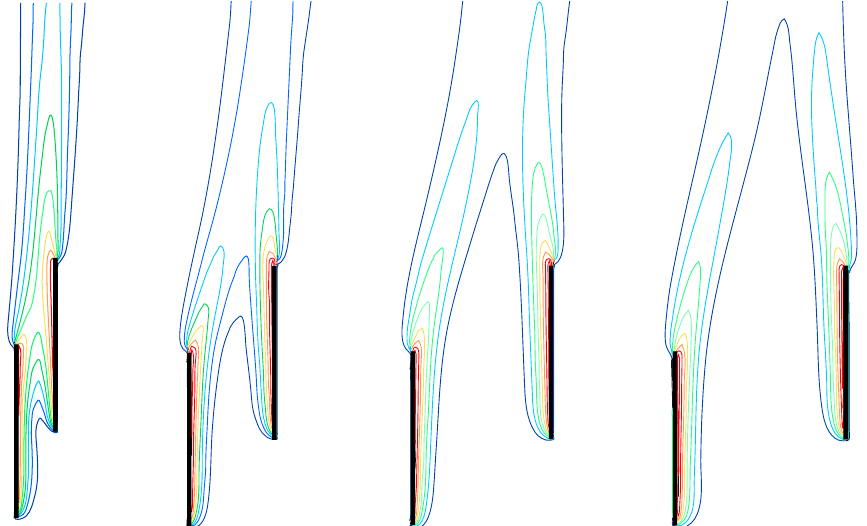
Figure 4. Isotherm contour plots for Ra H = 10 5 , L / H = 0.5 and W / H = 0.25, 0.5, 0.75, 1 using a scale from blue ( T = 0 ) to red ( T = 1 )